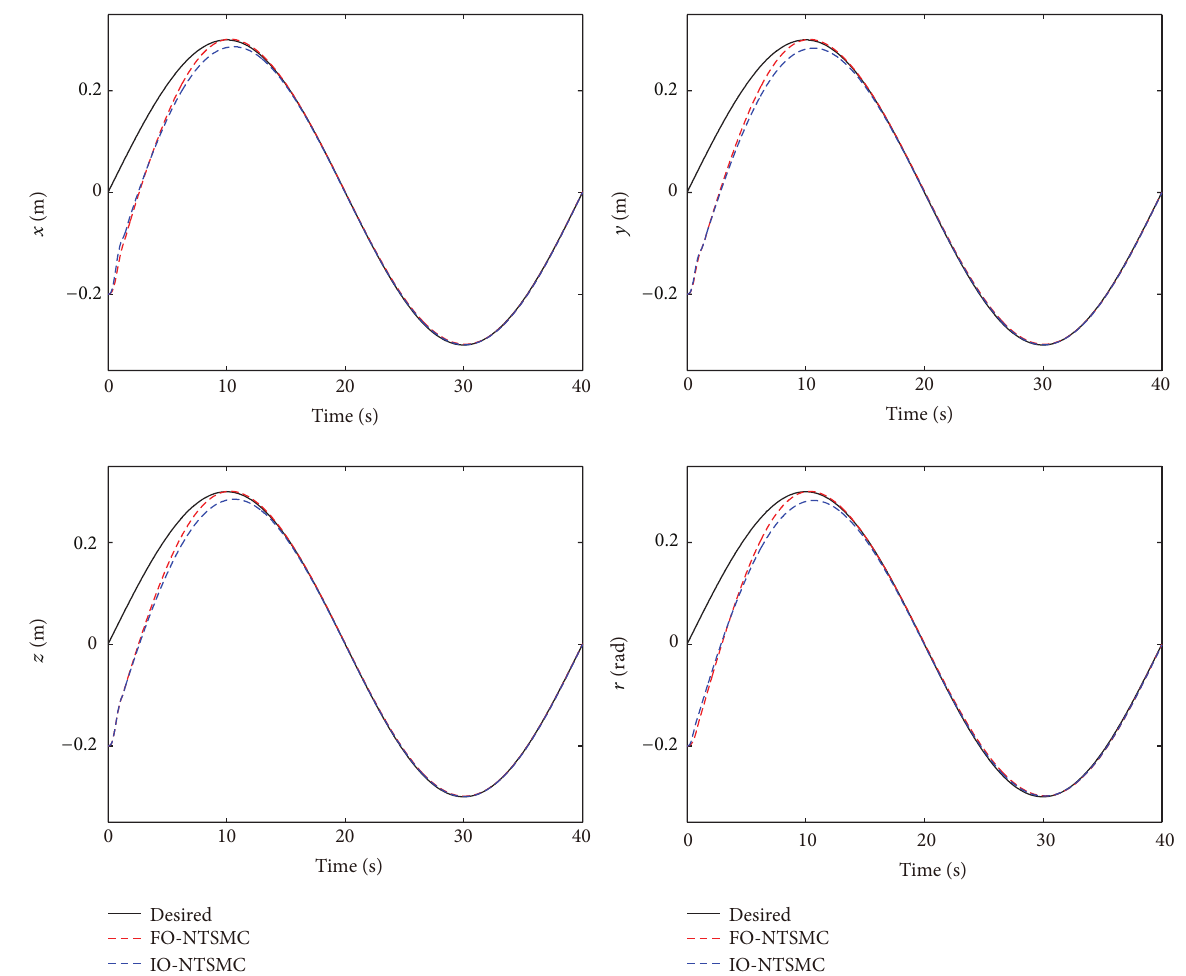
Figure 14: Trajectory tracking performance of output feedback FO-NTSMC and IO-NTSMC with boundary